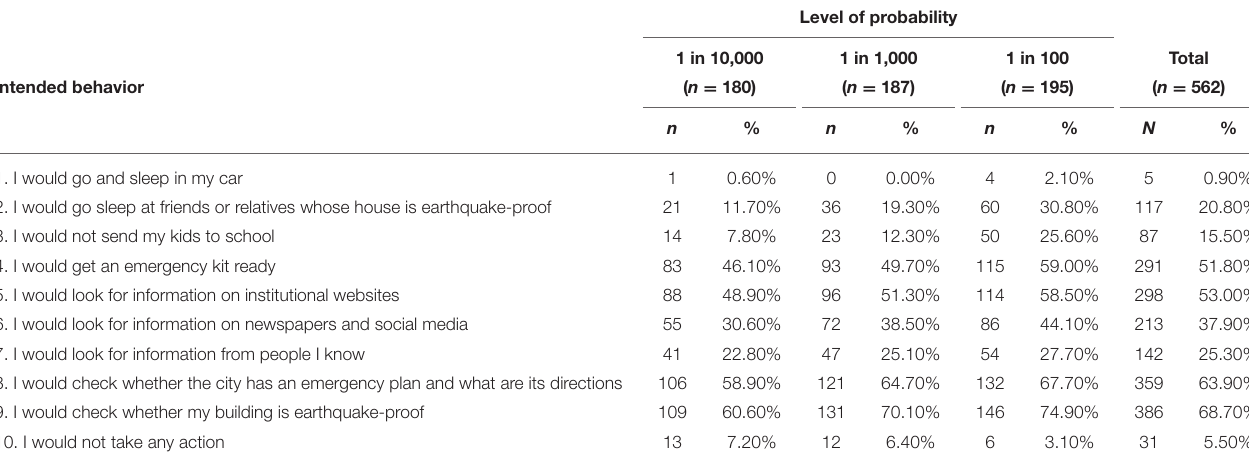
TABLE 3 | Frequency of times that each action was chosen by respondents for each level of